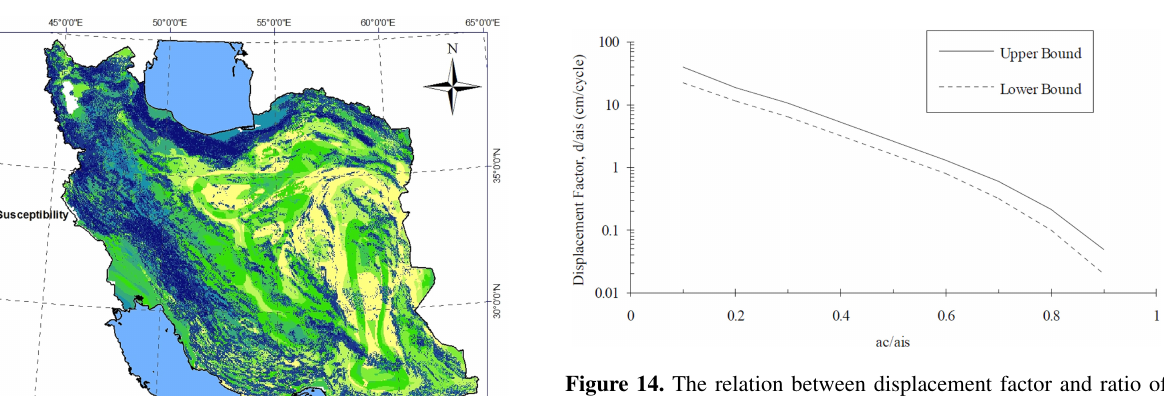
Figure 14. The relation between displacement factor and ratio of critical acceleration and induced